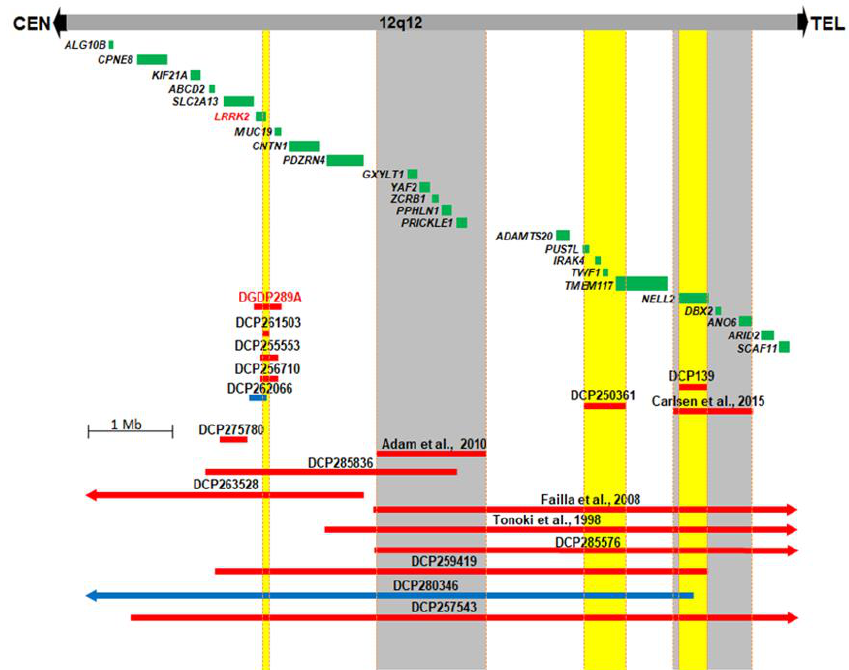
Figure 2. Comparative deletion mapping of CNVs at 12q12. Twenty-four genes residing in this 8.2 Mb chromosomal region are displayed. The microdeletion in our patient DGDP289A, in addition to thirteen unpublished DECIPHER cases, are displayed. The four published cases are also shown across this interval [13–15,18]. DGDP289A has a microdeletion involving only LRRK2 and MUC19 . CNV mapping with three microdeletions and one microduplication from DECIPHER database, along with DGDP289A, suggest LRRK2 as a likely candidate gene. Microdeletions are represented by red bars, while microduplications are in blue. The four chromosomal segments with gene deletions, likely producing clinical features such as developmental delay/intellectual disability and autism, are highlighted in yellow (new candidate gene regions) and in gray (reported candidate region). We cannot exclude the possibility that the syndromic intellectual disability in the DCP250361 of the third segment is caused by a position effect of a gene in the fourth candidate region.